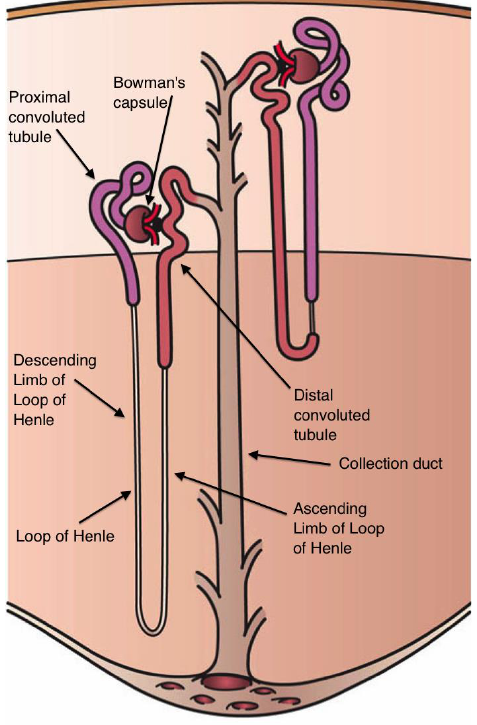
Figure 5. Components of the nephron (From Holly Fischer, Wikipedia commons).